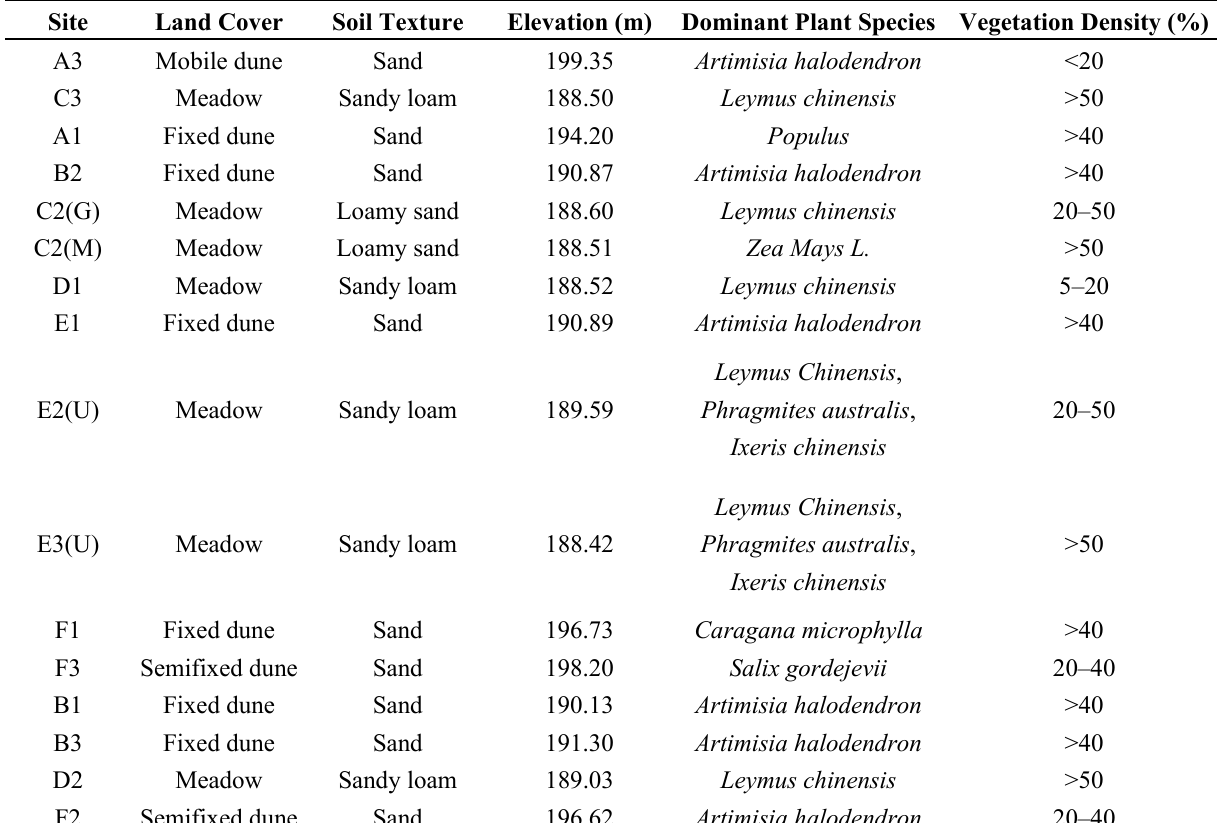
Table 1. Characteristics of the water table and hydrometeorologic